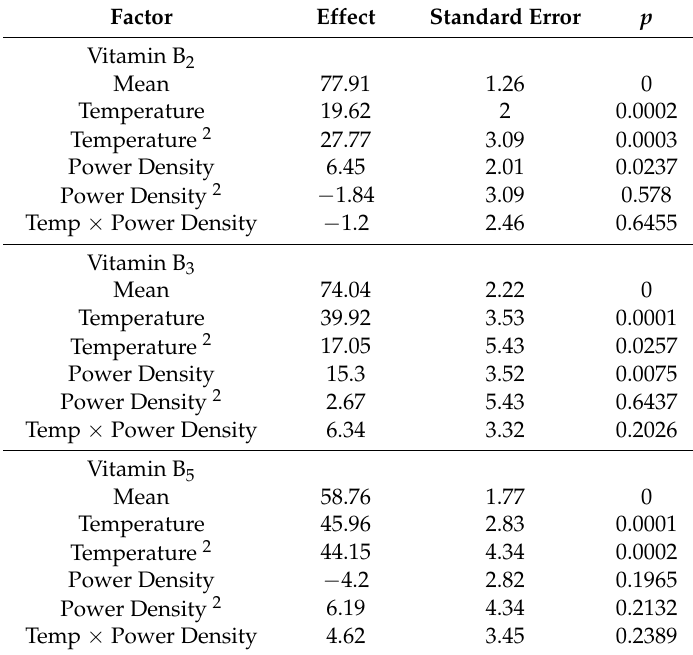
Table 2. Analysis of the perturbation of factors for vitamins B 2 , B 3 and B 5 in acerola juice subjected to ultrasound